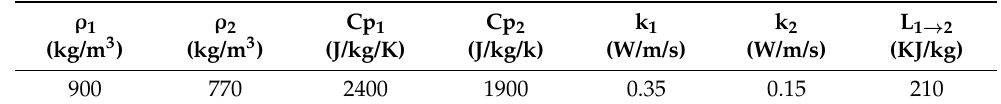
Figure 1. Model with phase change material. Table 1. Paraffins’ physical properties